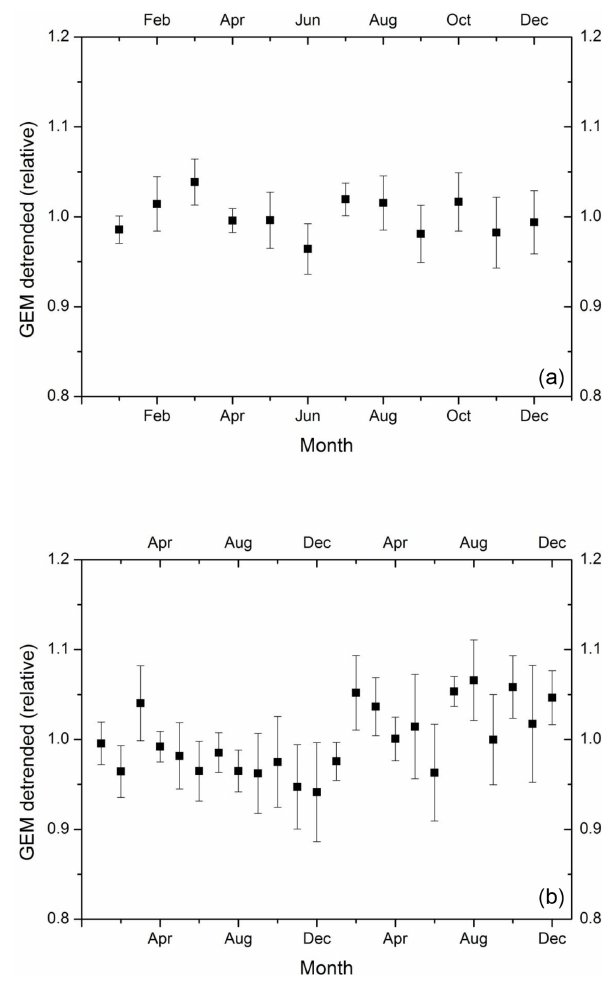
Figure 2. Seasonal (upper panel) and biennial (lower panel) varia- tion of detrended monthly averages. The error bars denote the stan- dard error of the monthly